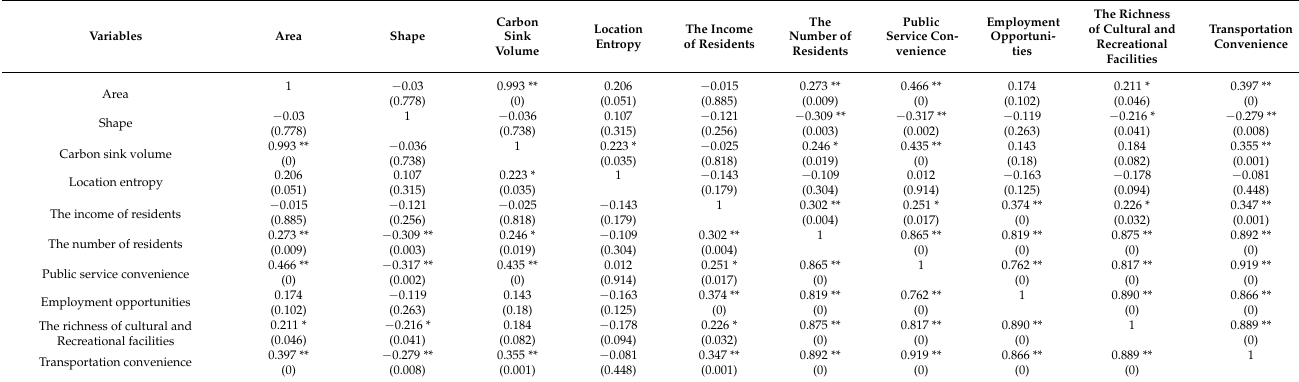
Table 6. Pearson correlation